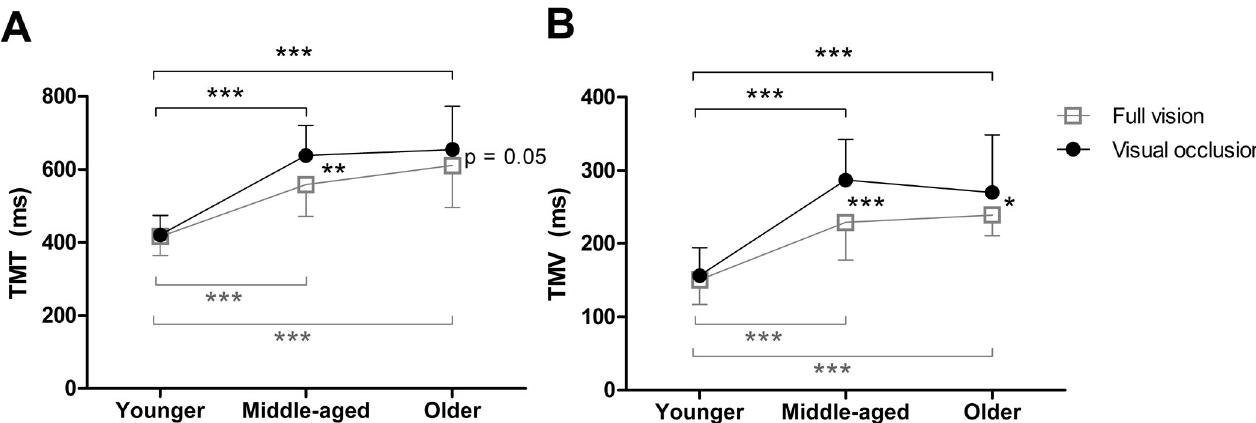
Fig 4. Illustration of age-by-visual condition interaction with post-hoc analysis. Total movement time (TMT) (A), time to maximum velocity (TMV) (B). P- values were shown for significance between the age groups and between the visual conditions with � p < 0.05, �� p = 0.002, ��� p � 0.001. Analyzing the difference between visual conditions in each age group using paired sample t-test; analyzing the difference between age groups in each visual condition using one-way ANOVA. Error bars represented standard